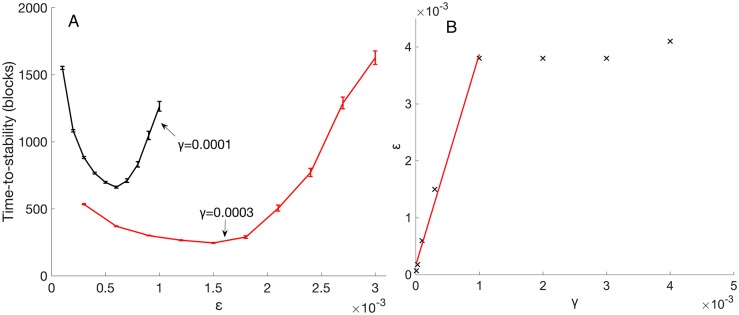
Matching ε to γ for fast development (A) Average time-to-stability is convex in ε. That is, at each value of γ, there is a value of ε that produces shortest time-to-stability. (B) Best ε for fastest development as a function of γ. For γ values larger than 0.001, the best ε is approximately the constant 0.004.